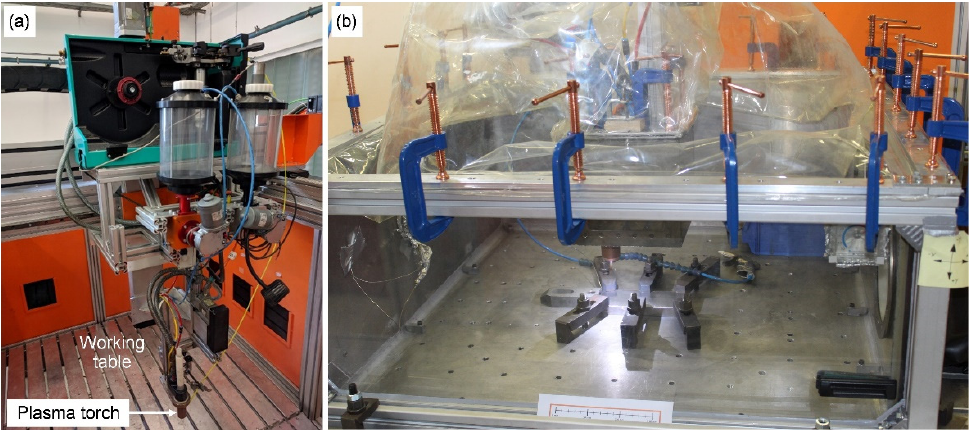
Figure 3. Setup of the PMD: ( a ) torch and feeder devices and ( b ) argon-purged processing cham- ber.